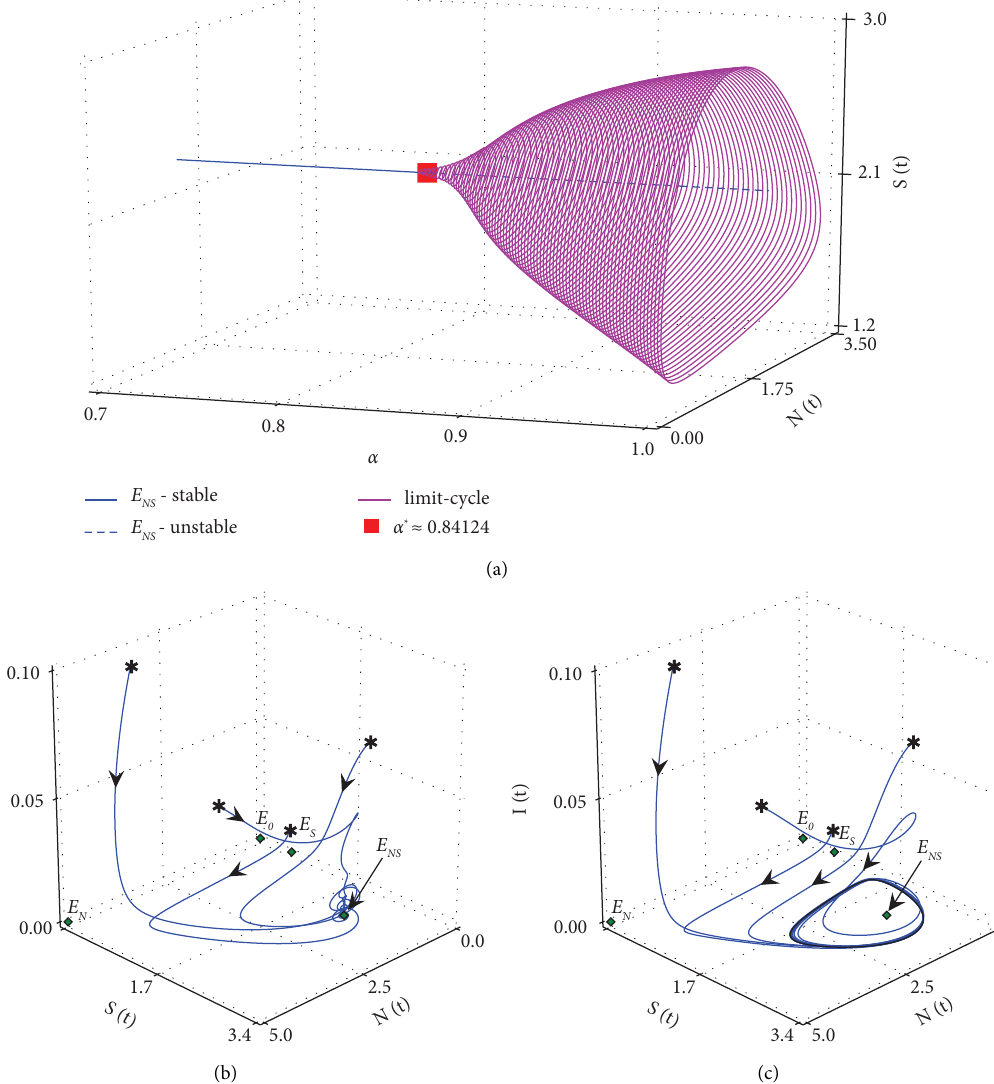
Figure 5: Dynamics of system (4) for the weak Allee efect case with parameter values (28). (a) Bifurcation diagram, (b) α � 0.82, and (c) α �